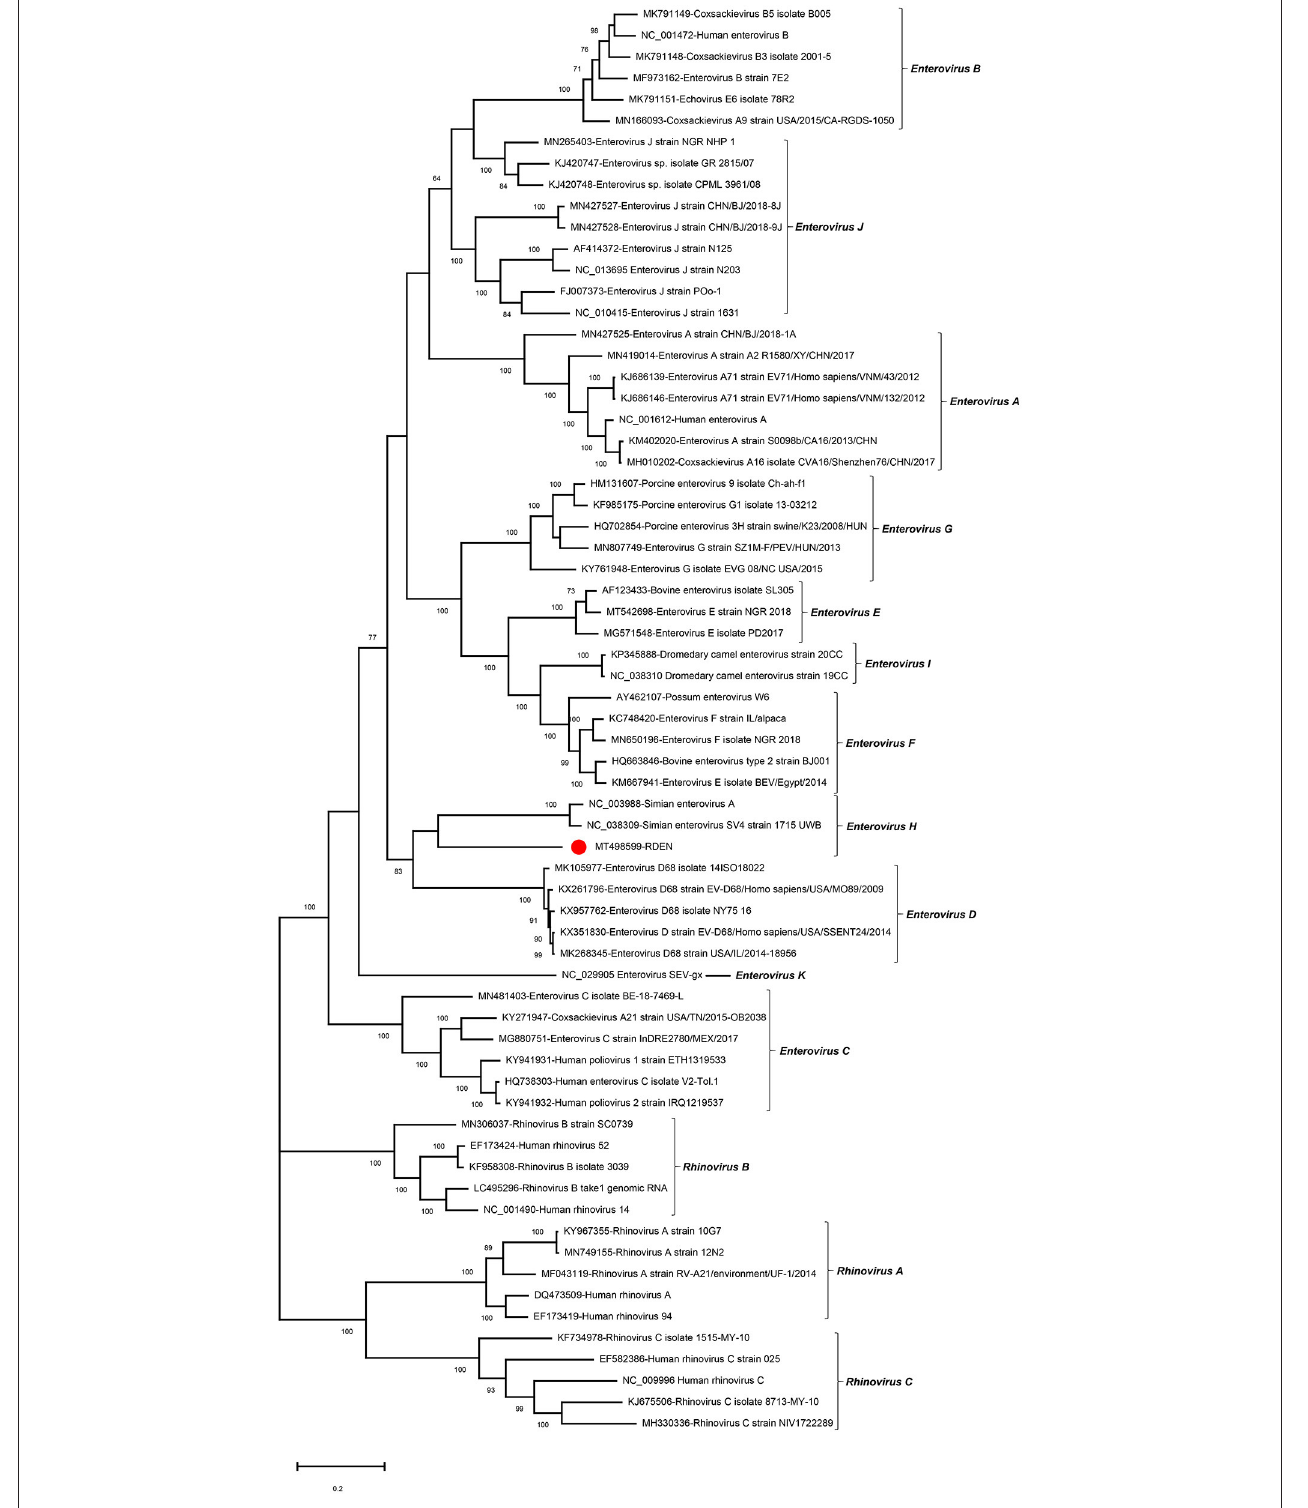
FIGURE 4 | Phylogenetic analysis based on the amino acid sequences of P1 + P2 of RDEN and reference strains of the genus Enterovirus in the family Picornaviridae . The RDEN identified in this study was marked with a red solid circle.